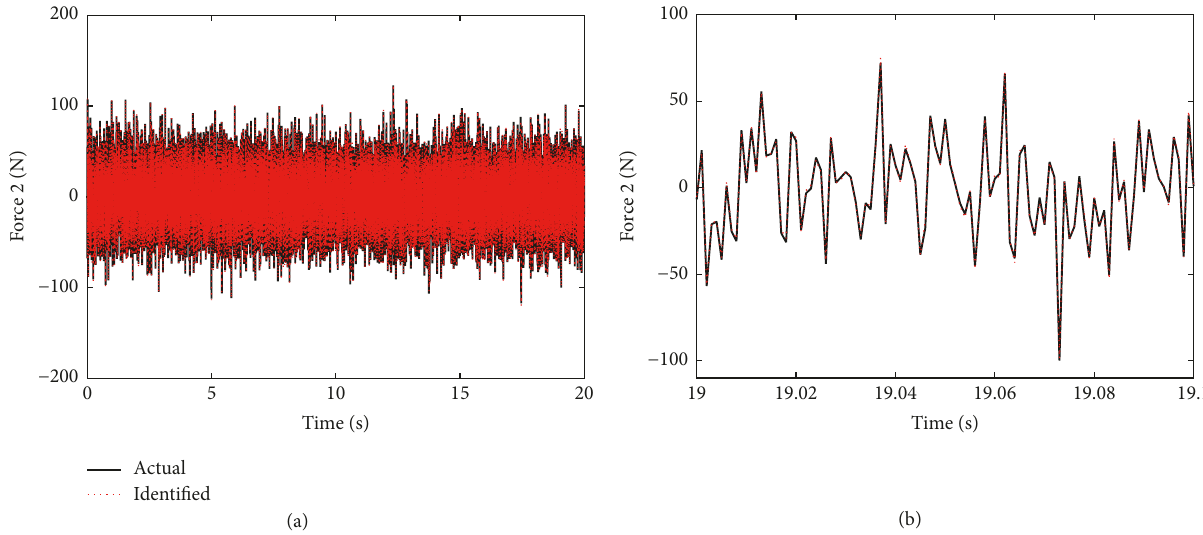
Figure 7: (a) The actual and identified results of force 𝑢 2 by data fusion. (b) Zoom-in view of a segment (19–19.1s) of